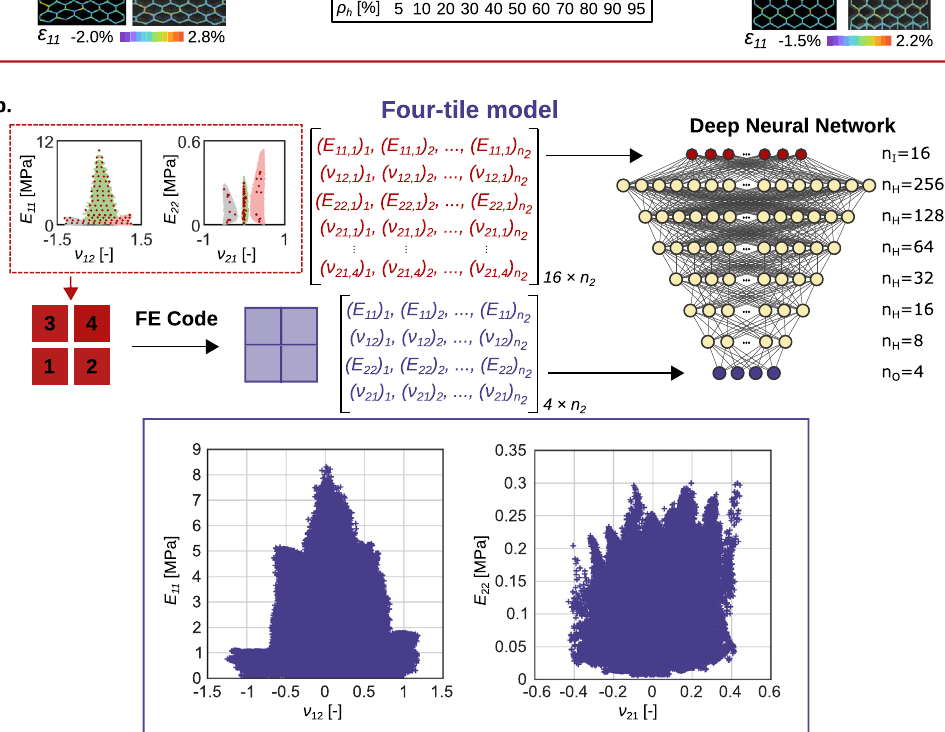
Fig. 1 The structures of the optimized deep learning models as well as relevant training procedures and the range of attainable mechanical properties. We trained two optimized deep learning models, namely single unit cell model ( a ) and four-tile model ( b ) for designing multi-material lattice structures. The strain distribution and deformation patterns obtained from FEM and DIC for selected representative designs are presented in ( a ). The prediction vs. simulation results and the coef fi cients of determination for the test datasets are, respectively, presented in Supplementary Fig. 2a and b for the single unit cell and four-tile models. Given the very large number of data points which makes the generation of the plots challenging, only the data points for which the FE models were directly solved (i.e., 1% of the data points) are plotted in Fig.